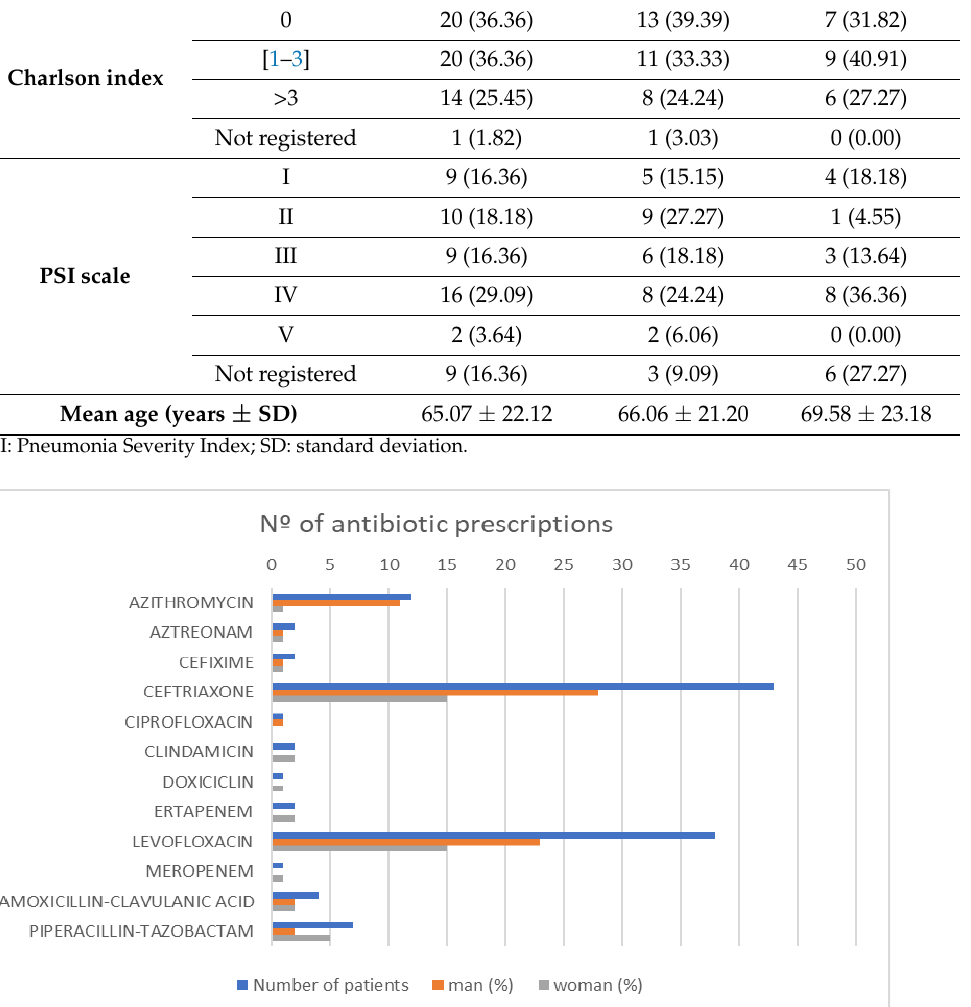
Table 2. Charlson Index, PSI scale and mean age.